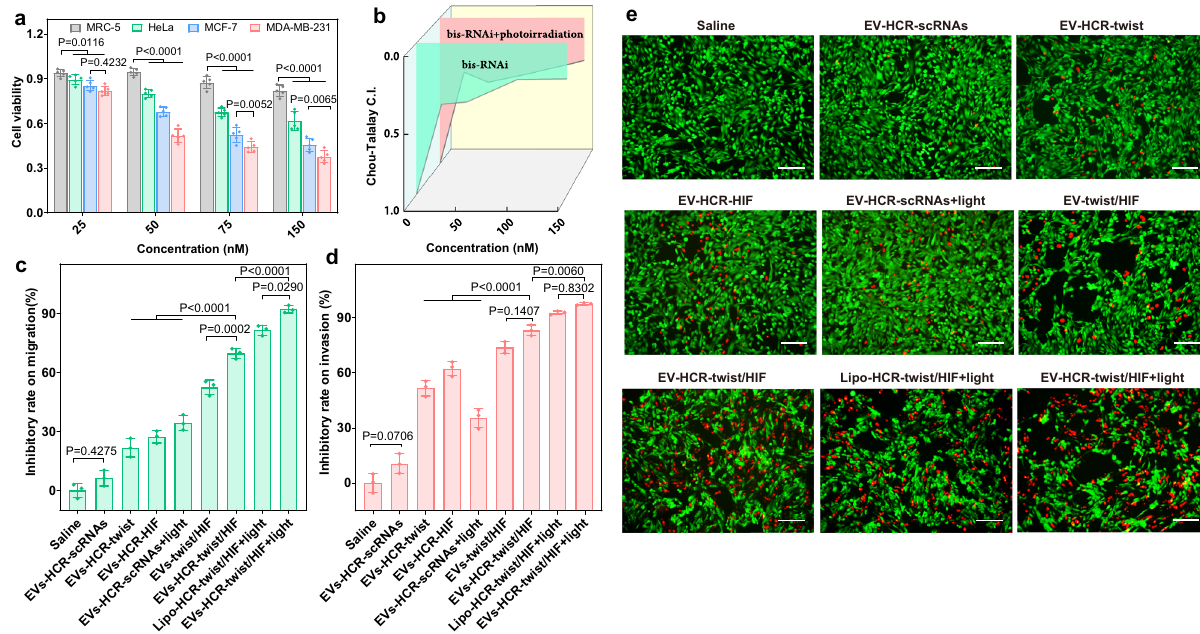
Fig. 3 Cell cytotoxicity evaluation of RNAi prodrug-packaged EVs under hypoxic conditions. a Cell viability of MRC-5, HeLa, MCF-7 and MDA-MB-231 cells after incubation with functional EVs containing with different concentrations of RNAi prodrugs (25, 50, 75 and 150 nM) for 48 h. Data represent the mean ± s.d. from fi ve independent replicates. Statistical signi fi cance is calculated by two-way ANOVA followed by Bonferroni ’ s multiple comparisons test. b Combination index (CI) values of the RNAi prodrug-packed EVs with and without photoirradiation. Results of c the transwell migration assay, d the Matrigel invasion assay and e live/dead cell analysis in MDA-MB-231 cells subjected to different treatments. All photoirradiation was carried out with an 808 nm laser (0.7 W/cm 2 ) for 5 min. Data represent the mean ± s.d. from either fi ve ( a ) or three ( c , d ) independent replicates. The images are representative of three independent experiments. Statistical signi fi cance is calculated by one-way ANOVA followed by Tukey ’ s post hoc test for c and d . All scale bars are 200 μ m. Source data are provided as a Source Data fi mice bearing ~300 mm 3 tumours were given tail vein injections of free ICG-RNAi prodrugs, ICG-RNAi prodrug-loaded liposomes